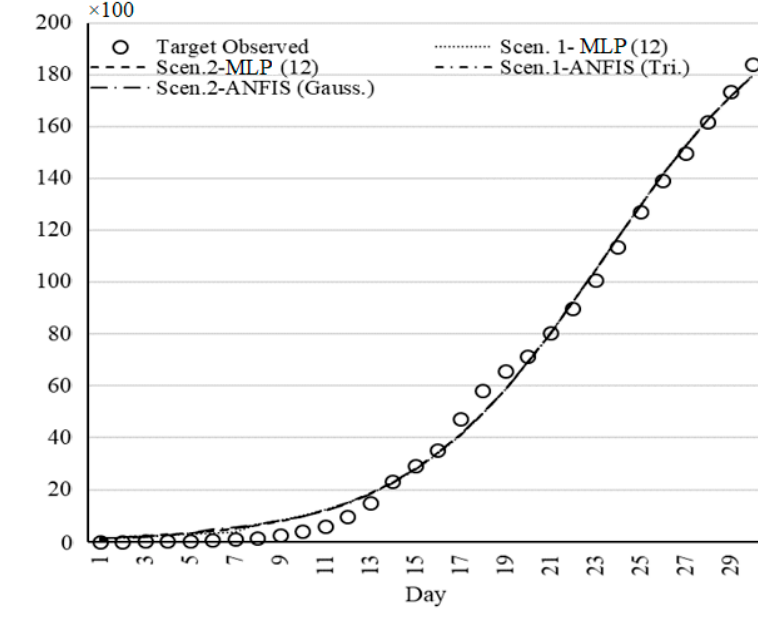
Figure 14. Set of models for Iran fitted by ML methods.